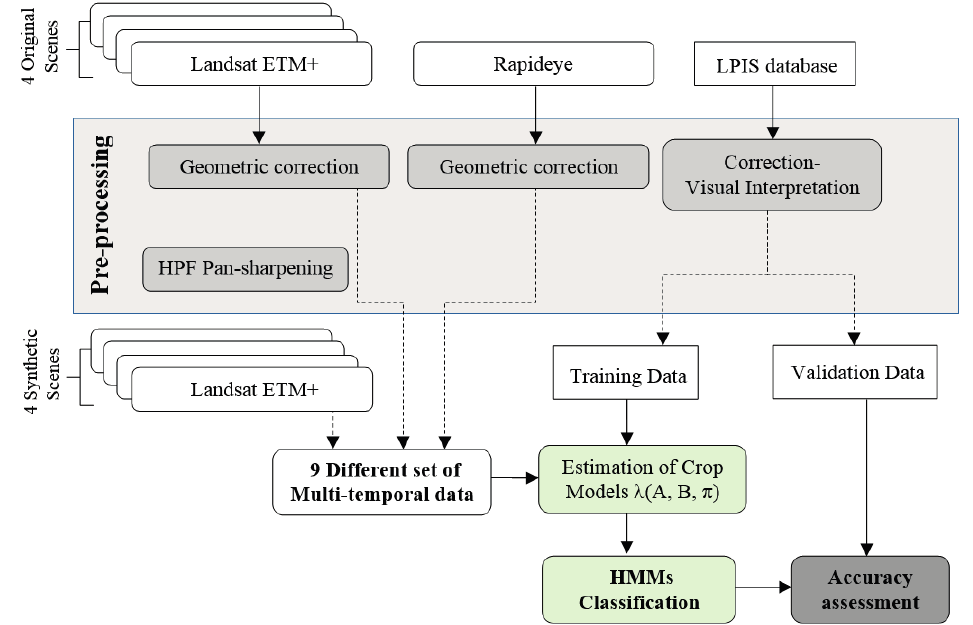
Figure 2. Overall process diagram of this research